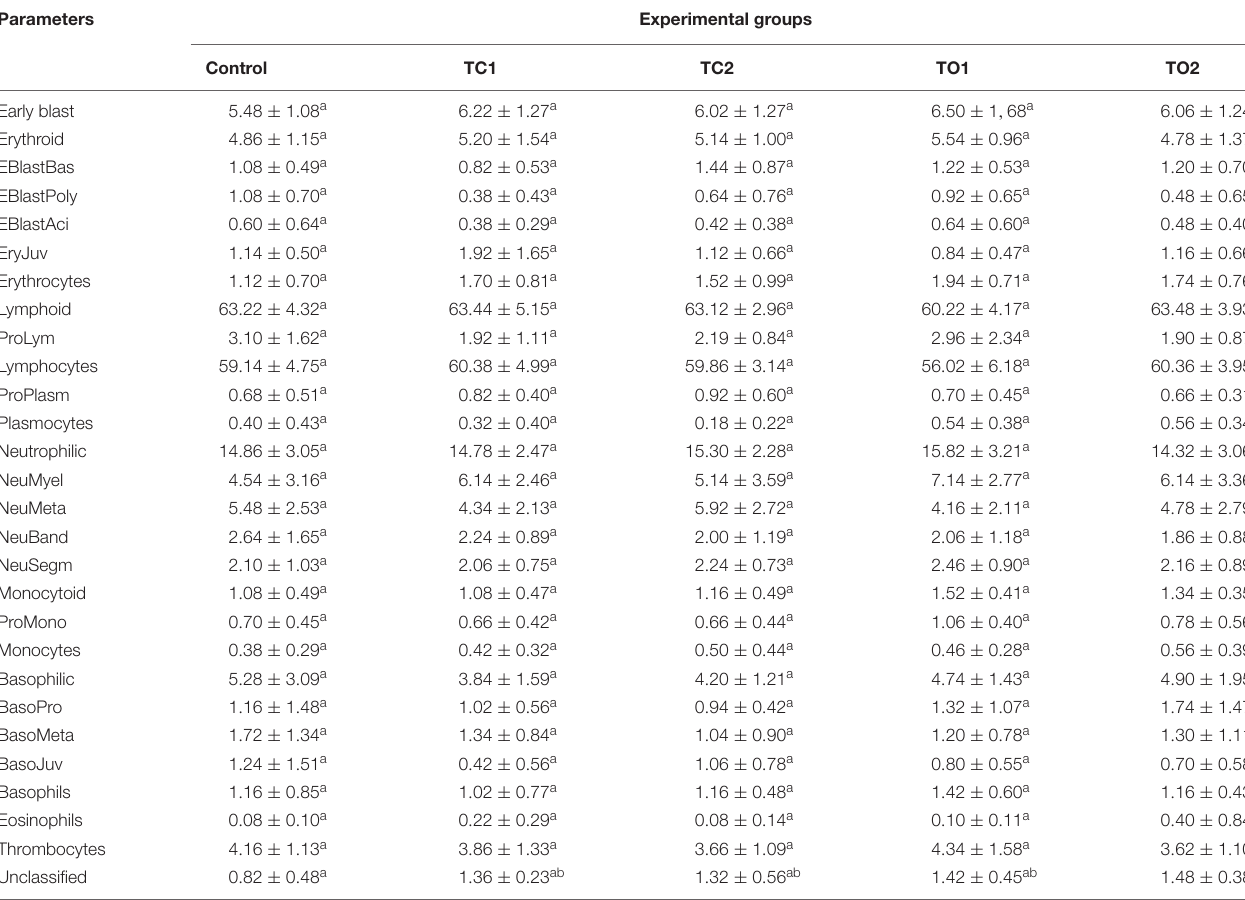
TABLE 2 | Cellular composition of head kidney hematopoietic tissue in common carp after oral application of phytochemicals. Parameters Experimental